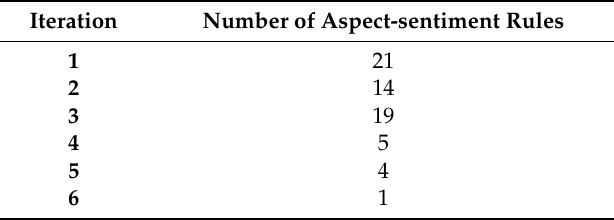
Table 7. Iteration and the number of aspect-sentiment rules.